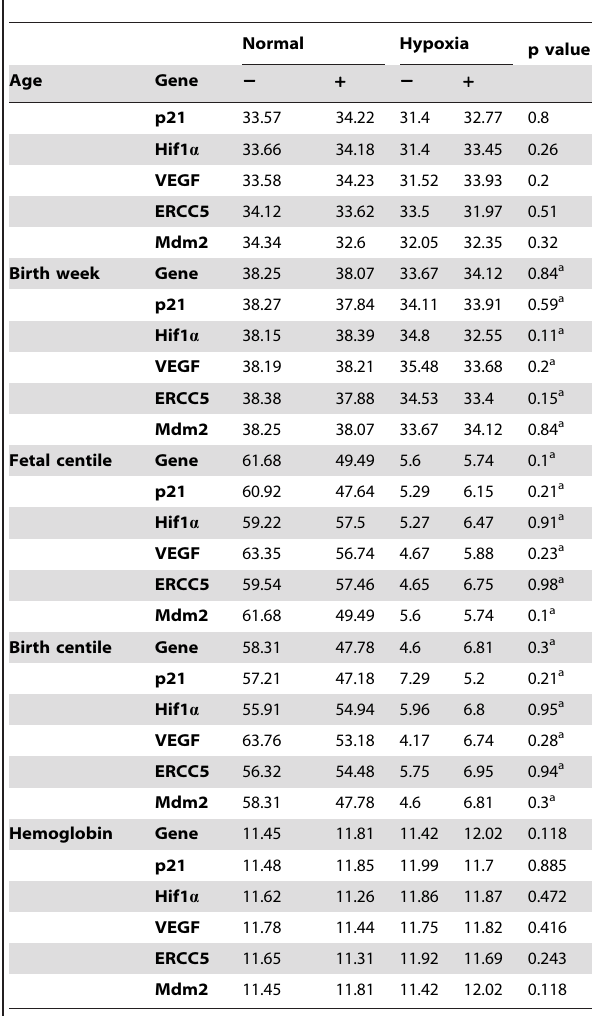
Table 5. Gene’s expression in the maternal plasma of twin pregnancies.